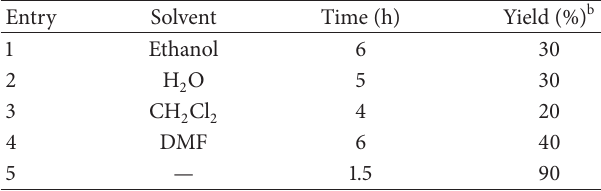
Table 1: Optimization of the reaction conditions a .